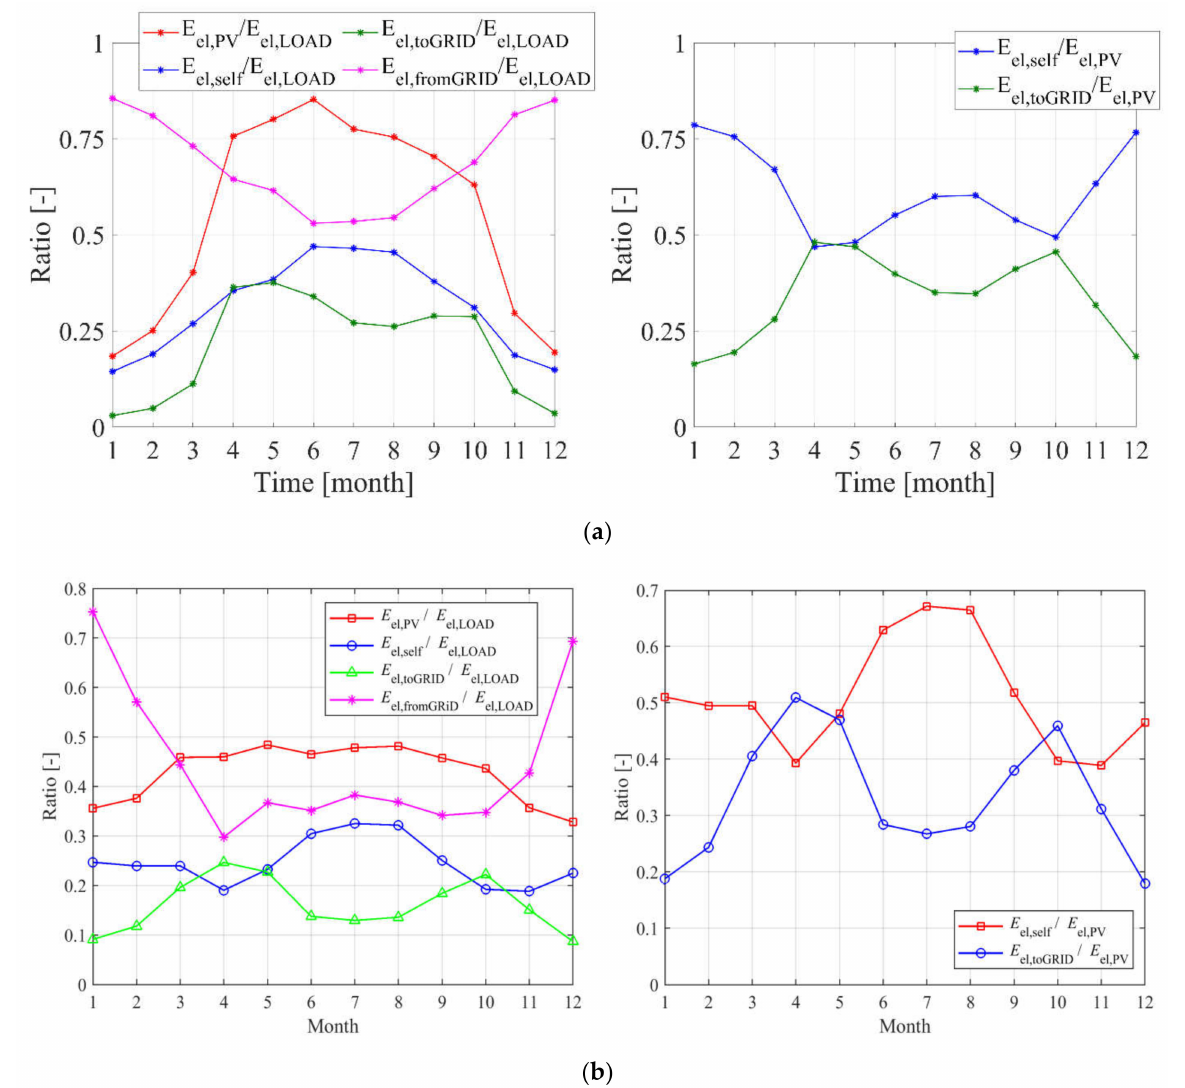
Figure 9. Monthly results of the energy ratios of the electric energy demand and energy ratios of the produced photovoltaic (PV) electric energy of the third proposed system (PS3) for the districts located in ( a ) Naples and ( b )